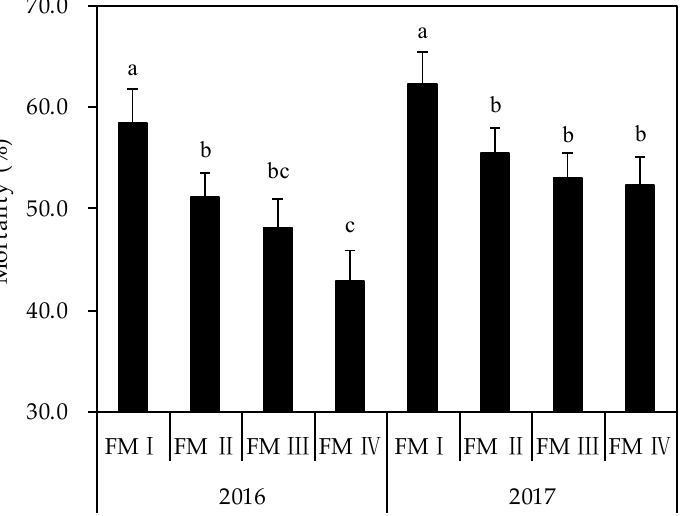
Figure 5. Effect of field margin (FM) size on earthworm mortality of arable field (AF) after applying rotary tillage. Data were medians and their 95% confidence intervals ( n = 3). Treatments having no letters in common represented significantly differences (S ‐ N ‐ K, p < 0.05 ).